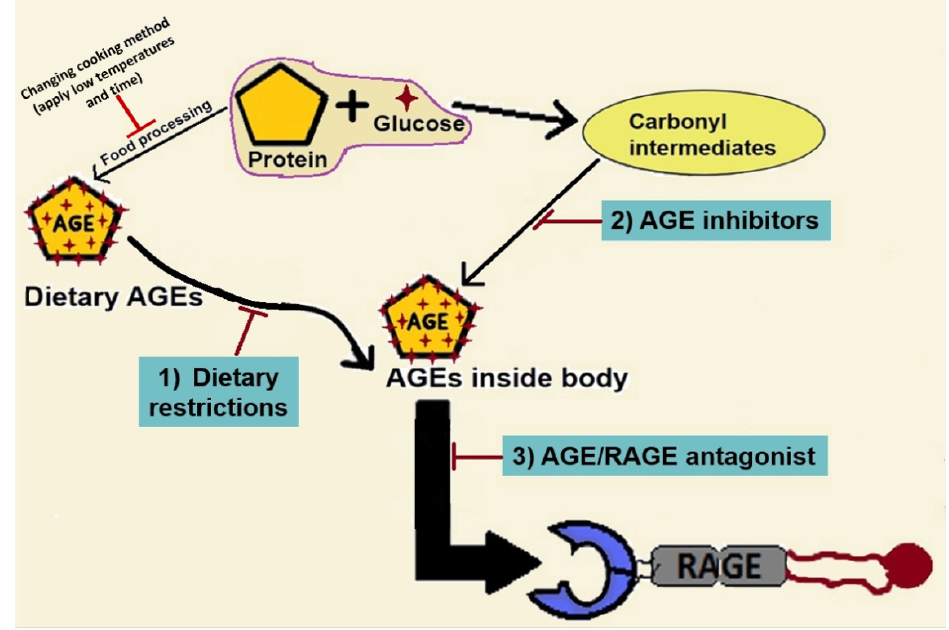
Figure 5. Therapies targeting AGE / RAGE axis. In the treatment and prevention of AGEs-induced NAFLD progression, three strategies could be adapted; ( 1 ) lowering dietary AGEs and precursors of glycation reaction, ( 2 ) inhibition of endogenous AGE formation and ( 3 ) inhibition of AGE / RAGE interaction. AGE: advanced glycation end products, RAGE: receptor for advanced glycation end products.